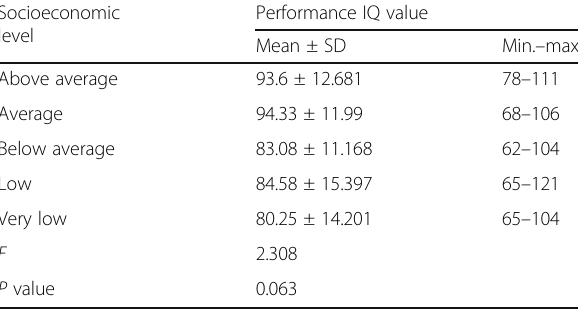
Table 4 Mean, minimum, and maximum of performance IQ scores in different socioeconomic